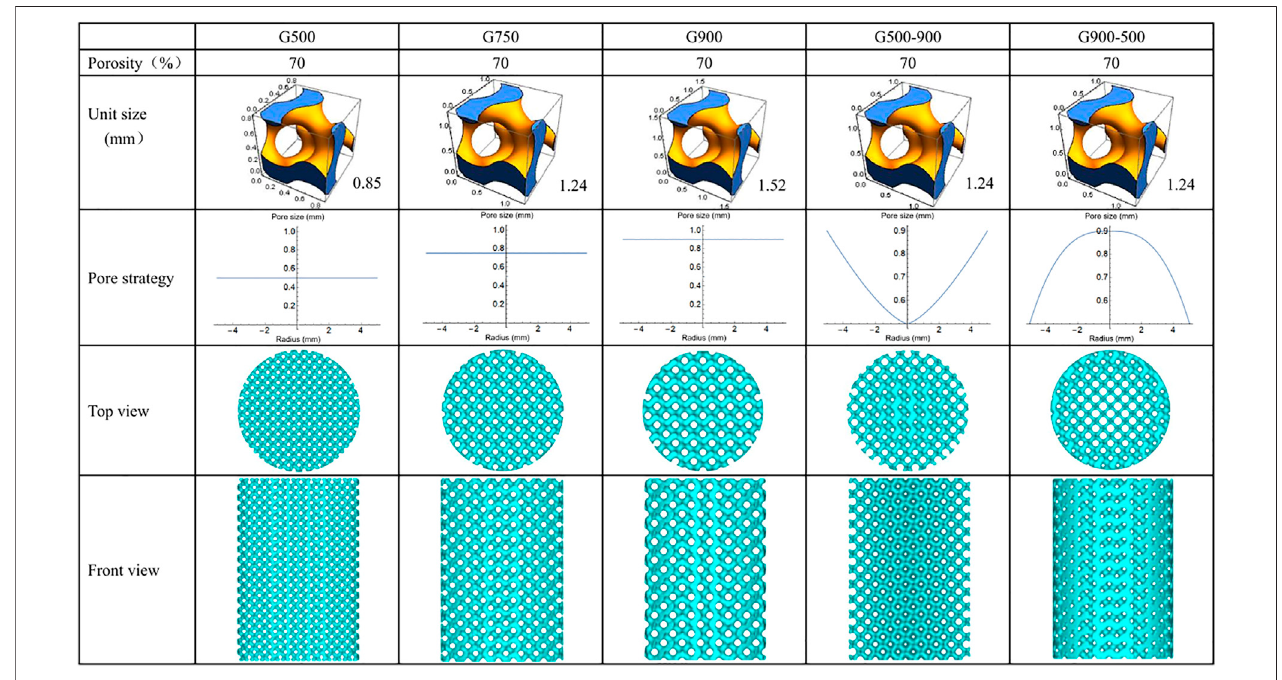
FIGURE 1 | Design model of the